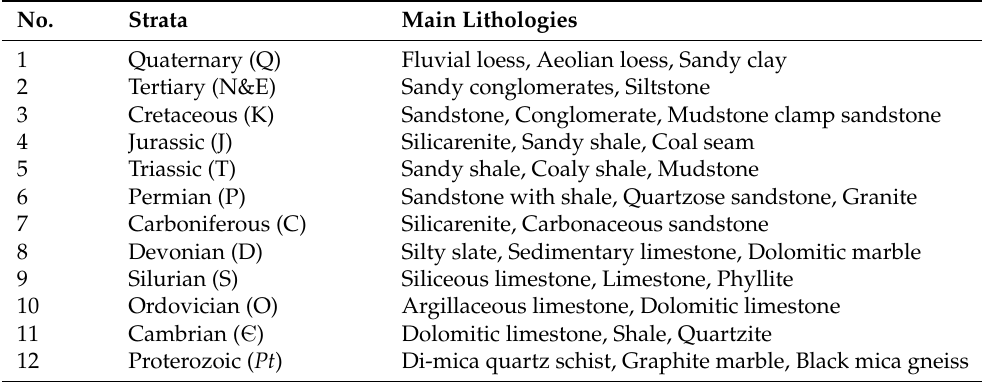
Table 1. Twelve stratigraphic ages and corresponding lithologies.